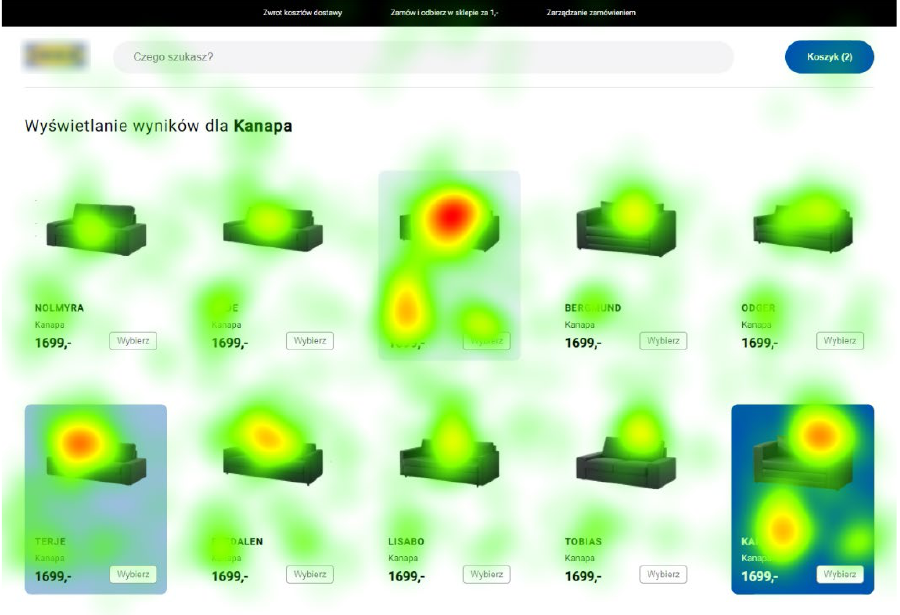
Figure 6. Heatmap for the first product category with background highlights. Source: own elaboration.